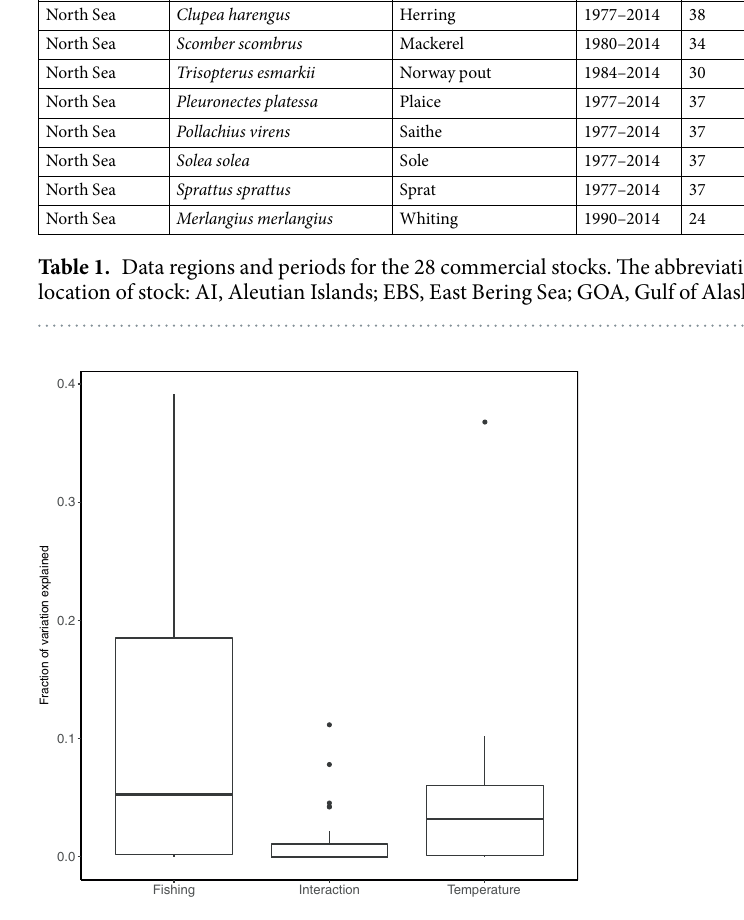
Figure 1. Boxplot showing the variation of size structure explained by the fishing, temperature, and interactive effect. Results of ANOVA indicate that the fraction of variation explained by fishing is significantly higher than the temperature ( P = 0.019) and interactive effect ( P = 0.00023), but the fraction of variation explained by temperature is not significantly different from interaction ( P =